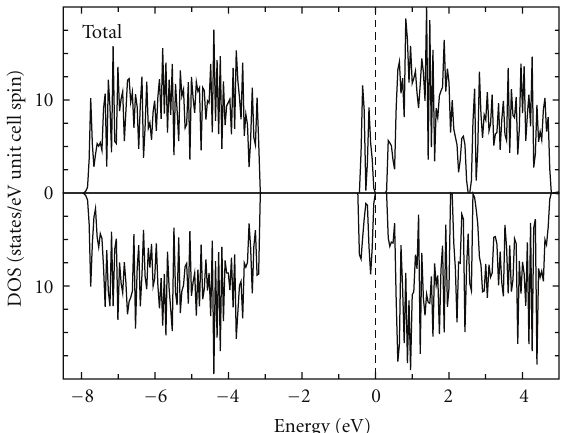
Figure 22: The total DOS obtained from LSDA+ U calculations with U = 3 . 0 eV and J = 0 . 8eV for the low-temperature P 1 phase of Ti 4 O 7 [187]. The top of the valence band is shown by dotted lines.